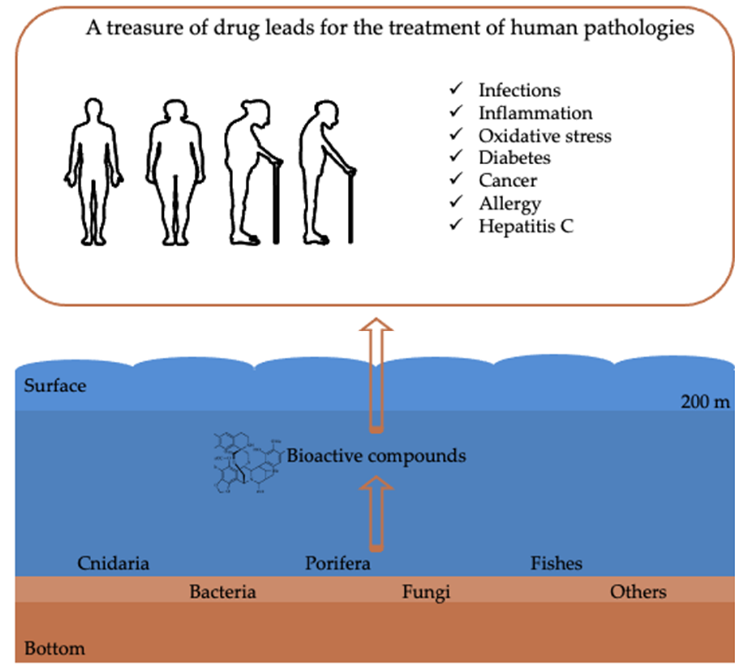
Figure 2. Schematic representation showing the main deep-sea marine organisms from which com- pounds with bioactivities useful for the treatment of human pathologies have been reported. Arrows indicate the flow from sampling of marine organisms from deep environments to the identification of bioactive compounds and possible applications for the treatment of human